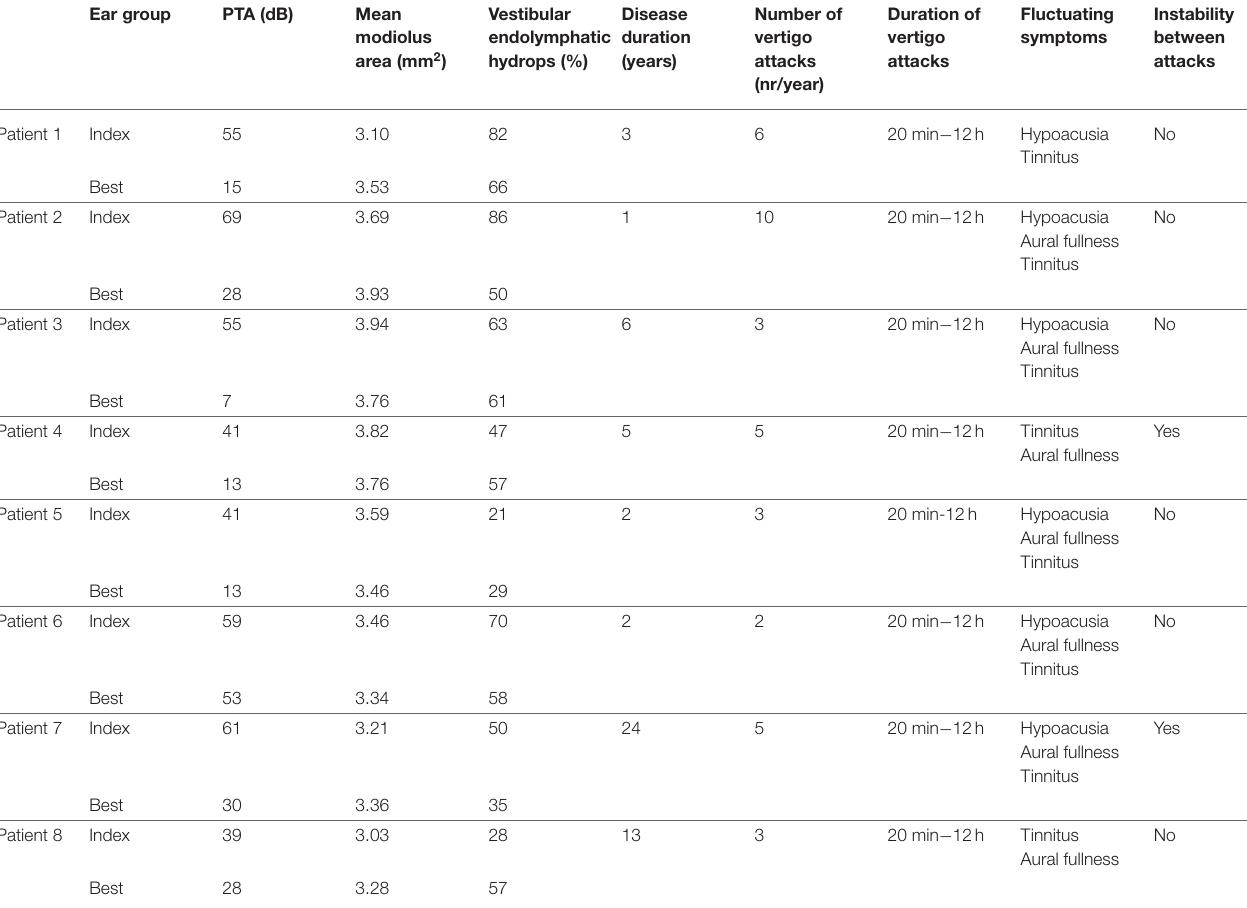
TABLE 1 | PTA, mean modiolus area, vestibular endolymphatic hydrops, and disease duration of worst and best ears of eight patients with clinical criteria of definite MD. Ear group PTA (dB) Mean